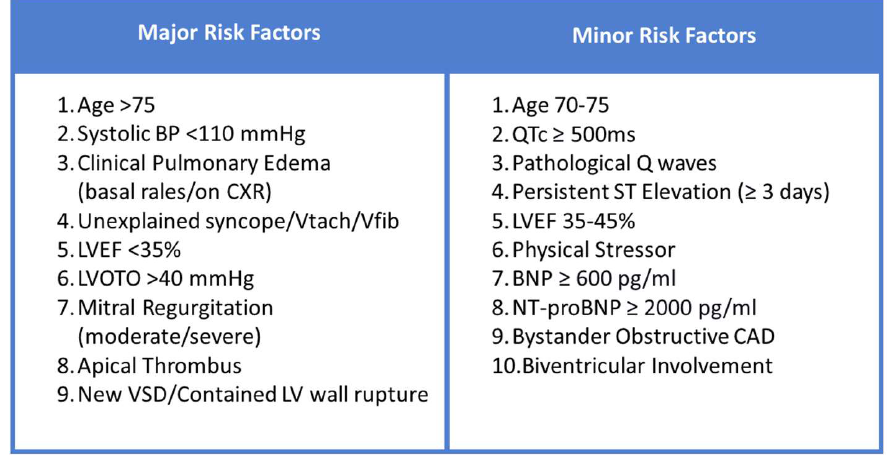
Figure 4. European Society of Cardiology (ESC) Heart Failure Association Risk Stratification of TS [8].